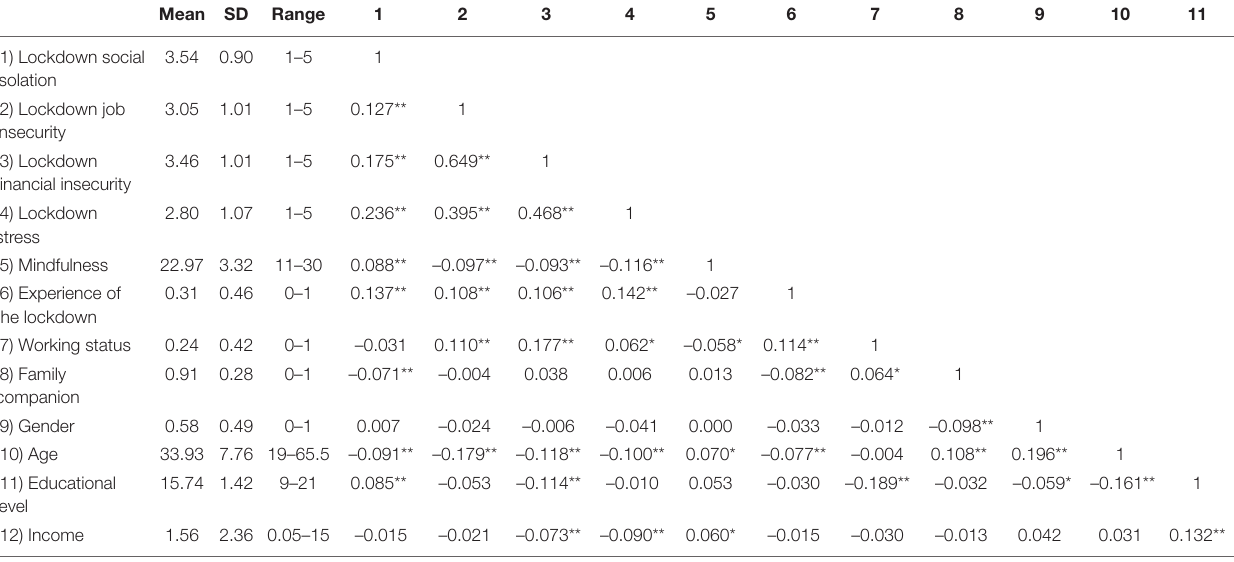
TABLE 1 | Mean, standard deviations, and correlations matrix for the whole sample.